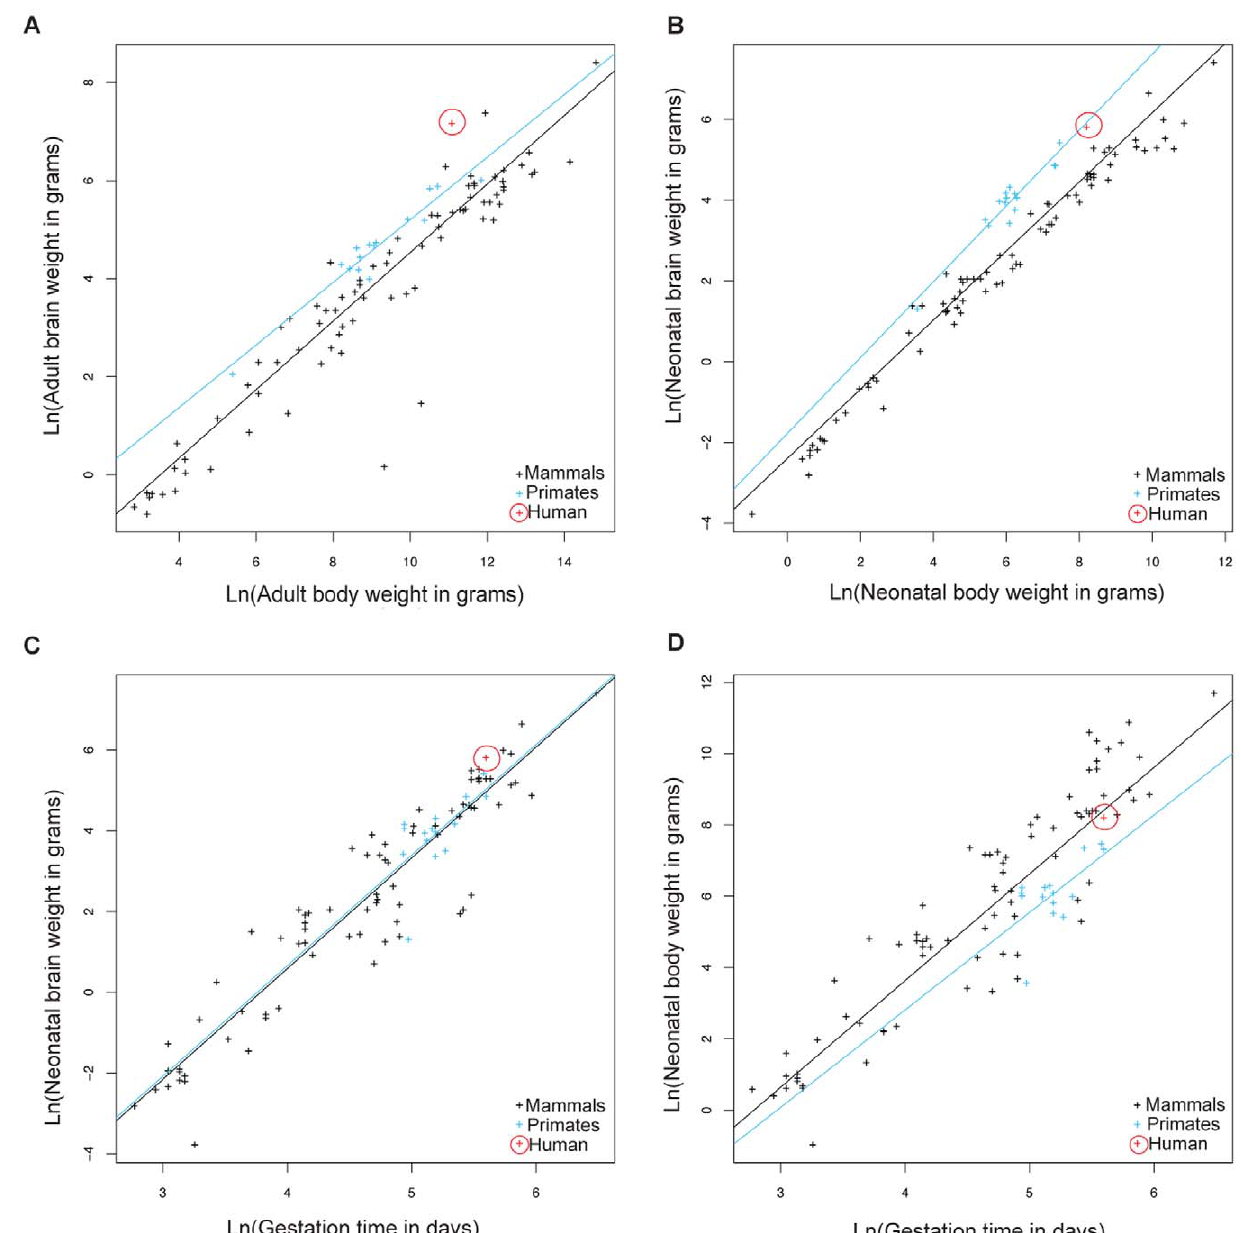
Figure 1. Allometric analysis of brain size, body size, and gestational length by linear regression. Brain to body weight ratios for adults (A) and neonates (B) are shown for humans (red), other higher primates (blue), and other mammals (black). The black line shows least squares fits to the 91 mammalian species. Neonatal brain (C) and body size (D) to gestational time ratios are displayed for the same species. The blue line shows least squares fits to 15 higher primate species. Allometric data was acquired by Sacher and Staffeldt (1974)